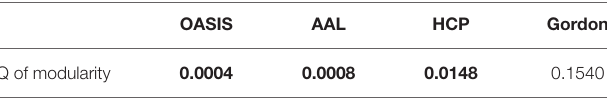
TABLE 5 | P -values of Kruskal-Wallis testing for modularity differences among the NC, EMCI, LMCI, and AD groups. OASIS AAL HCP Gordon Q of modularity 0.0004 0.0008 0.0148 0.1540